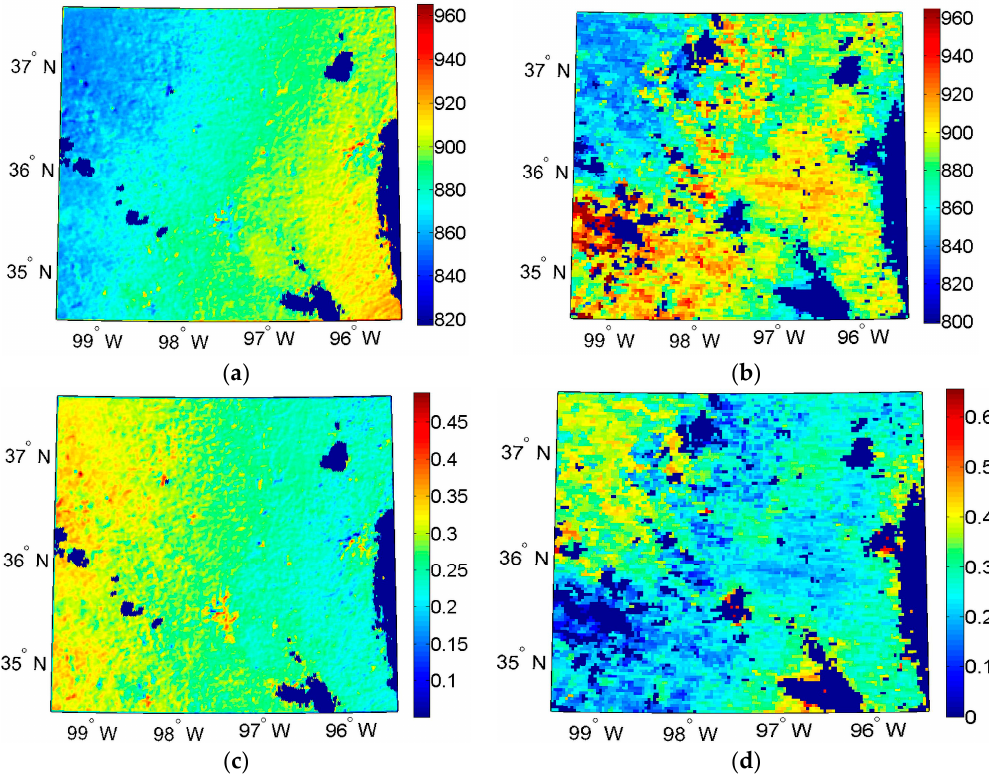
Figure 6. Spatial pattern of estimated ( a ) SARA-based global irradiance and ( b ) MODIS-based global irradiance using ( c ) 1-km SARA AOD and ( d ) 3-km MODIS AOD on 20 July 2014 over the SGP. In the left maps, the violet color represents no information because of cloud cover and in the right maps no information because of both cloud cover and missing values in the MODIS product.